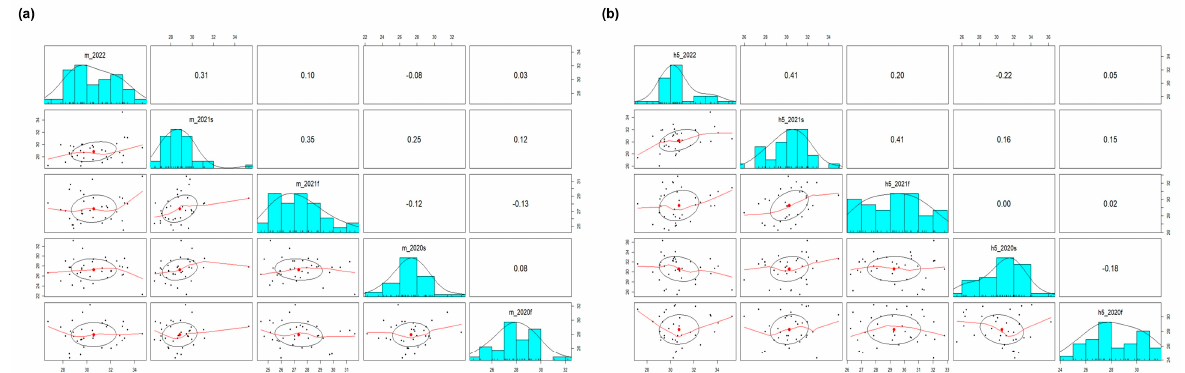
Figure 3. Pairwise correlation analysis of the Ct values of a CDS among the five proficiency tests. Ct values for ( a ) M and ( b ) H5 genes of a CDS from the 36 laboratories participating in all proficiency tests (2020 first half, 2020 second half, 2021 first half, 2021 second half, and 2022) were used to find correlations in their results. The numerical values and red line graphs represent the correlation between the Ct values of labs in two different proficiency tests. The higher the numerical value or the upward − sloping graph, the higher the correlation. The correlation between result of previous PT test and next PT test appeared after 2021 first half, which means that the labs with higher Ct values in 2021 first half showed consistently higher Ct values in 2021 second half and 2022.